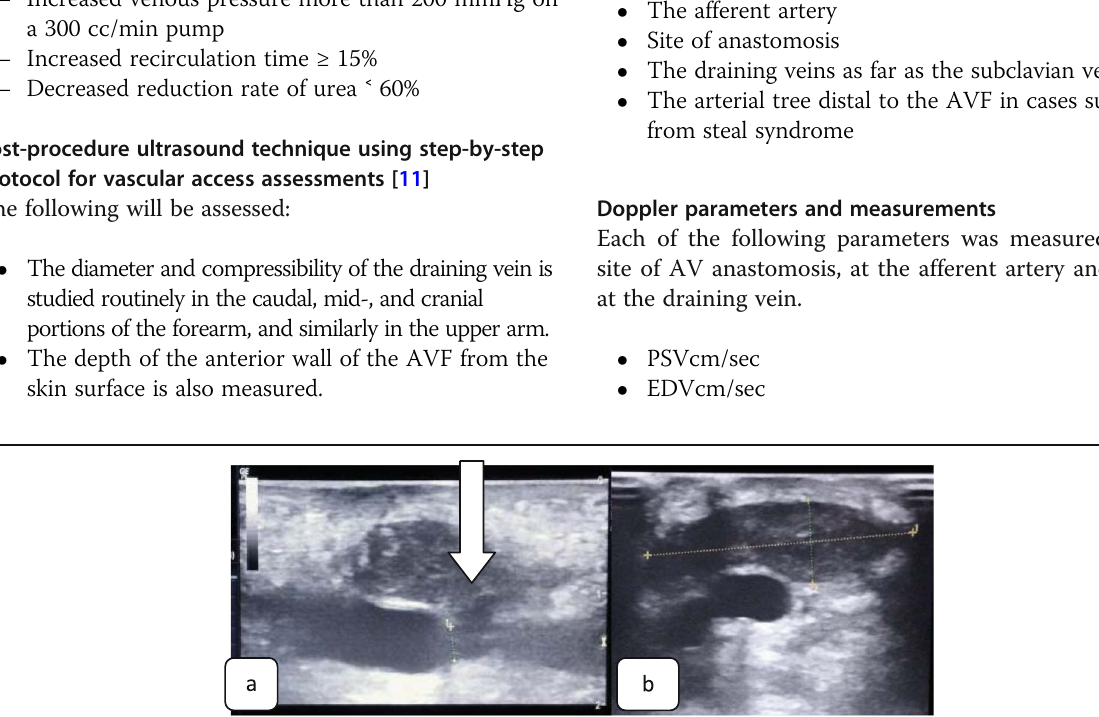
( n = 60) Patients referred from primary center ( N = 30)